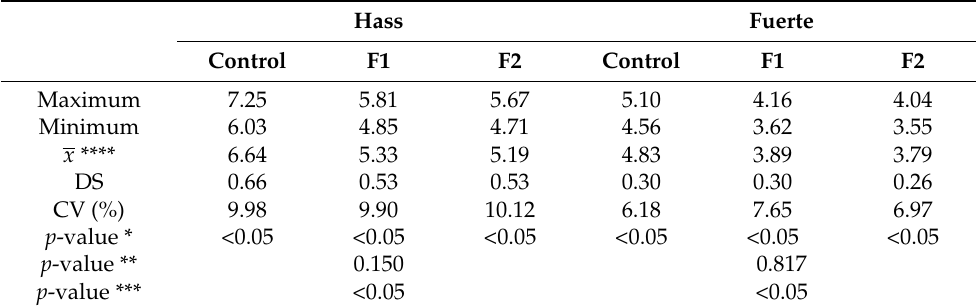
Table 6. Weight loss (%) of control and coated avocado.